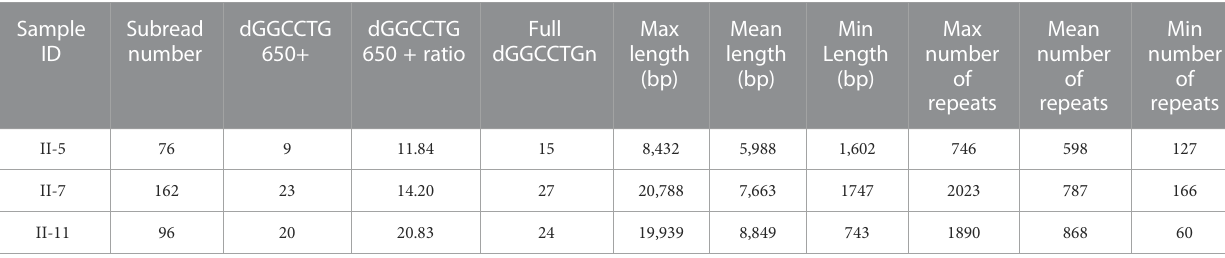
TABLE 2 The statistics based on SMRT sequencing about the subreads.